Question: Give a one-sentence summary of this figure.
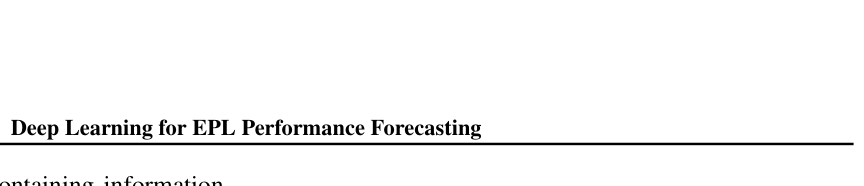
Answer: Goalkeeper Predictions vs. True Performance (Holdout Data)